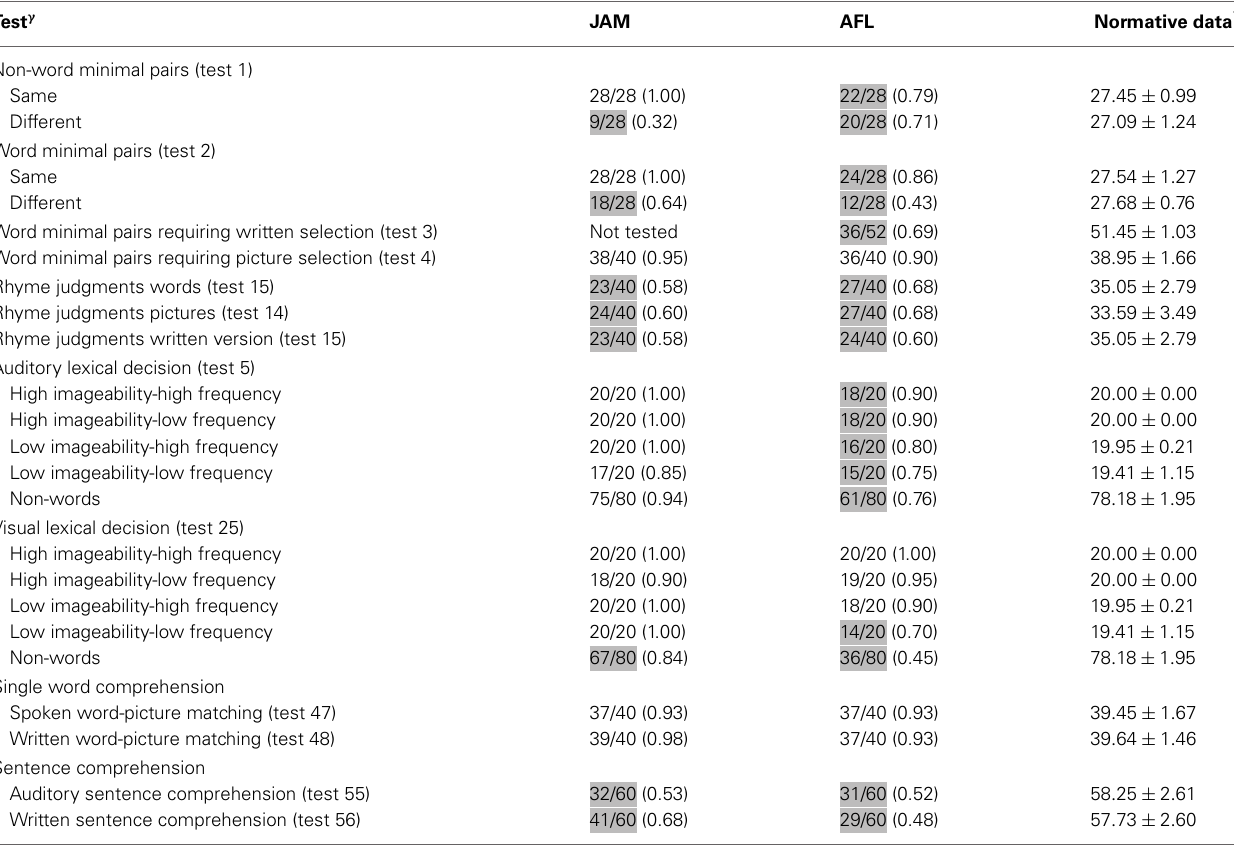
Table 1 | Auditory and reading